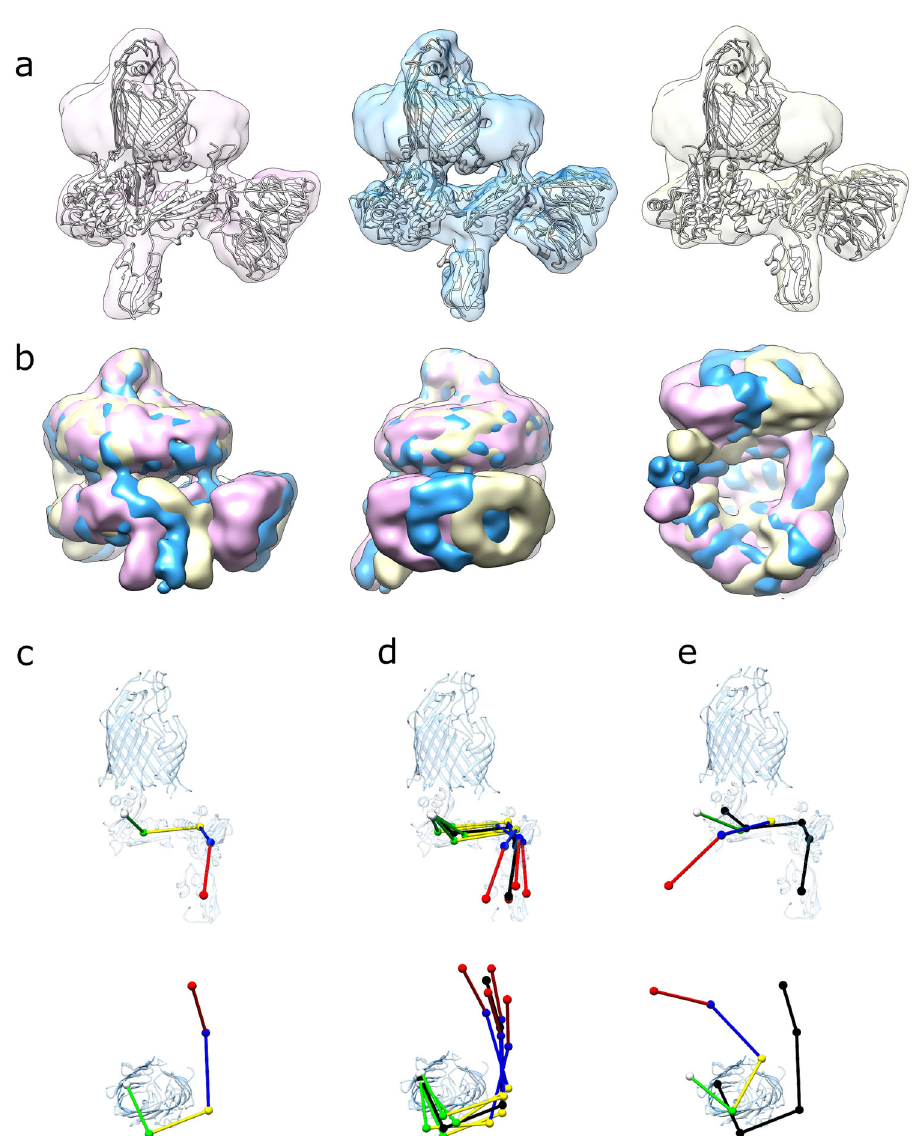
Fig. 5 Cryo-EM structures generated by separation along eigenvectors 0 and 1. a EM maps of (left to right) conformations 0 – 1, 0 – 5 and 0 – 9, with fi tted models. Each reconstruction is aligned on the β -barrel of BamA illustrating the difference in orientation of the bottom half of the complex. b EM maps of conformations 0 – 1 (pink), 0 – 5 (gold) and 0 – 9 (blue) aligned on the β -barrel of BamA and overlaid. c Positions of centres of mass for POTRA domains 1 through 5 (red, blue, yellow, green and white, respectively) in the BAM-nanodisc consensus structure. d Positions of the POTRA domains in the four extremes of the ensemble (0 – 1, 0 – 9, 1 – 2 and 1 – 8, respectively, coloured) compared with the consensus structure (black). e Comparison of the positions of the POTRA domains in the ‘ lateral closed ’ crystal structure (5D0O 13 , coloured) with the BAM-nanodisc consensus structure